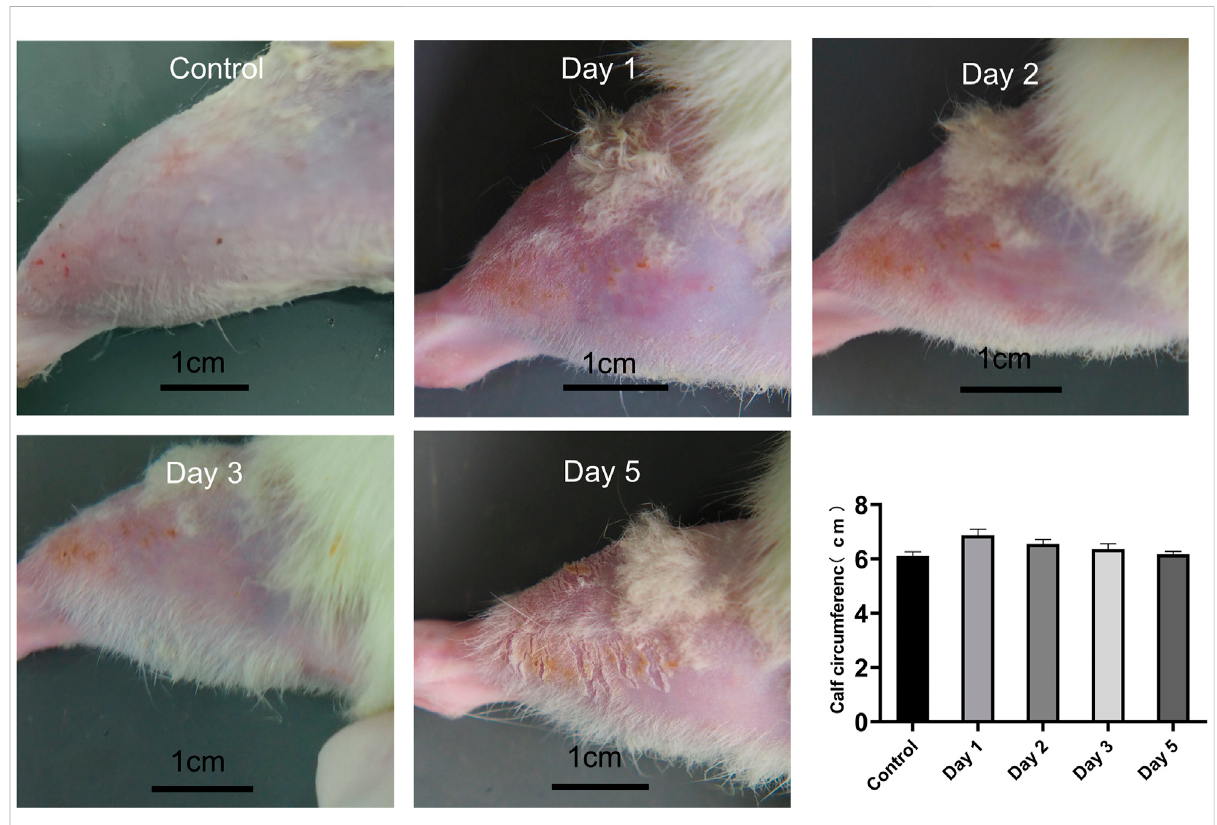
FIGURE 4 Calf condition of rats at different time points, and calf circumference at different time points ( n = 10). Scale bar = 1 cm.